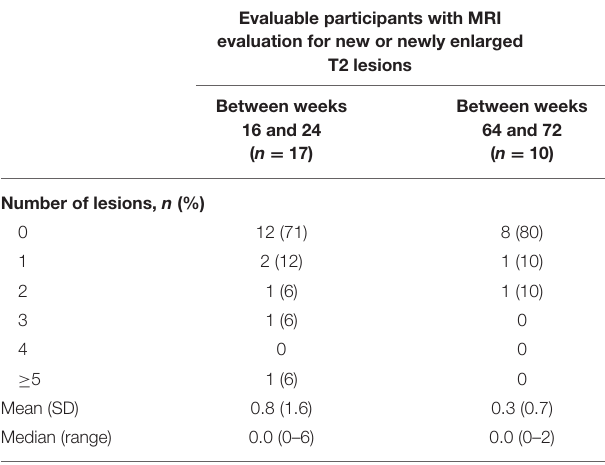
a lymphocyte count ≤ 0.5 × 10 9 /L and three participants had a lymphocyte count < 0.8 × 10 9 /L during the study period. None of